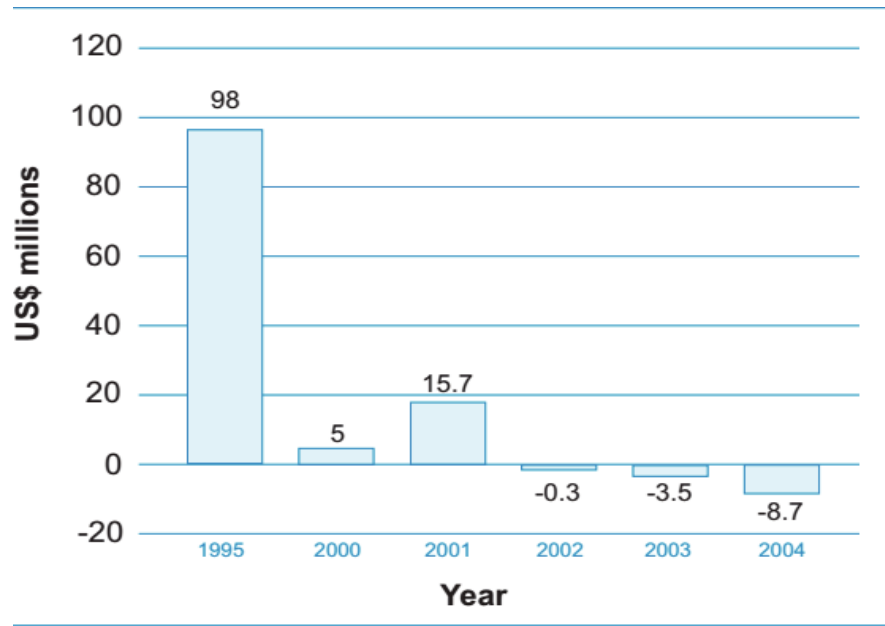
Figure 1: The 1995- 2004 Net FDI